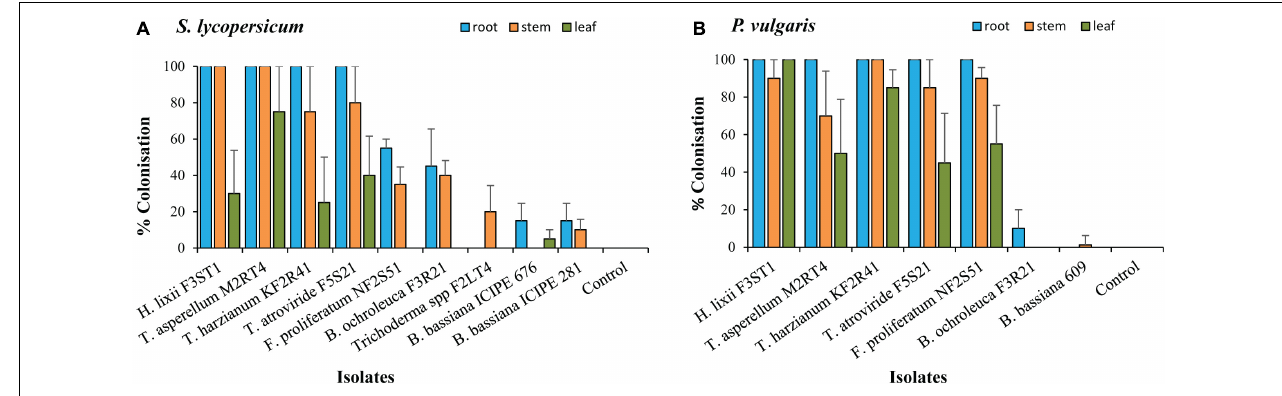
FIGURE 1 | The colonisation of different parts of Solanum lycopersicum (A) and Phaseolus vulgaris (B) plants by endophytic fungal isolates of Beauveria bassiana (ICIPE 609, 676, and 281), Bionectria ochroleuca F3R21, Fusarium proliferatum NF2S51, Hypocrea lixii F3ST1, Trichoderma spp F2LT4, T. asperellum M2RT4, T. atroviride F5S21, and T. harzianum KF2R41. Error bars represent the SE ( ± SE) of the means at 95% CI (Tukey’s HSD test, P ≤